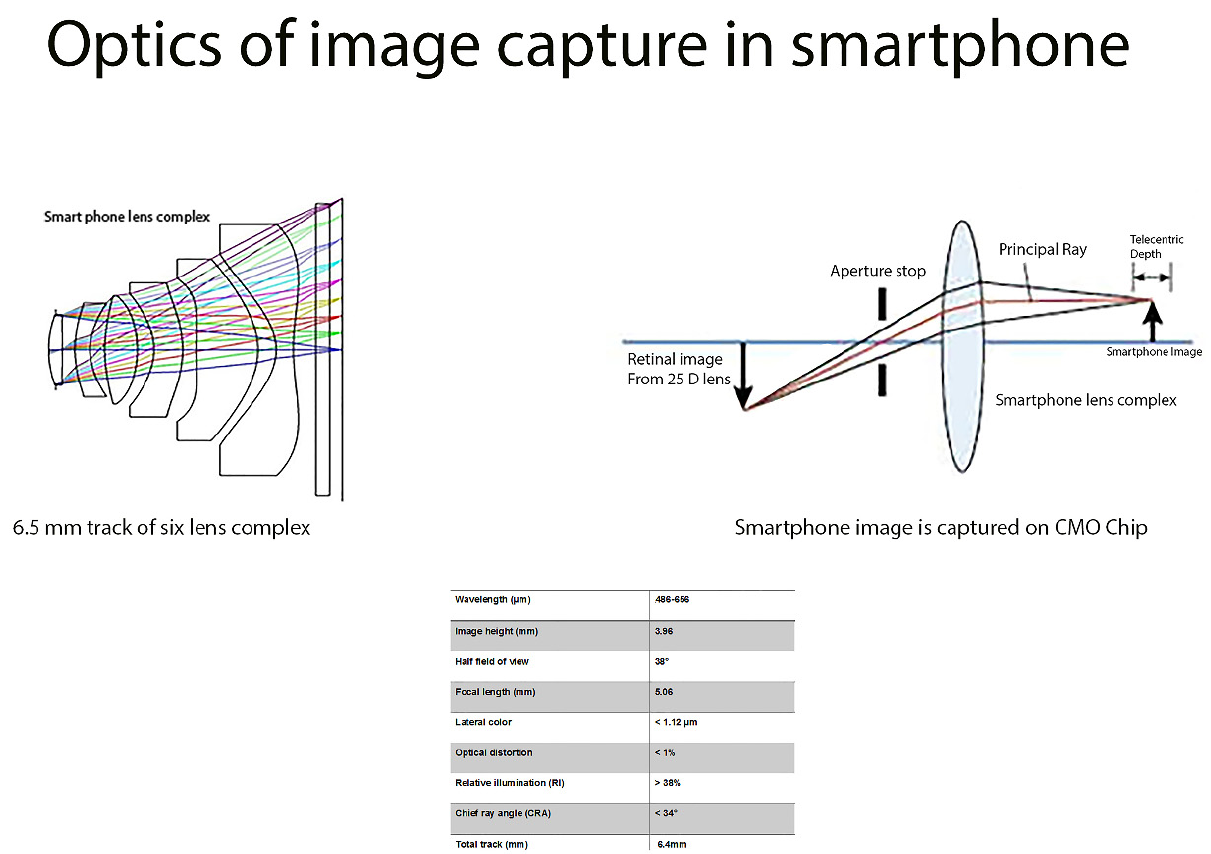
Figure 3. The smart phone lens complex has approximately 6.5 mm total track of lens with about 5.067 mm effective focal length and image height of 3.96 mm. The smart phone image is captured on the CMO